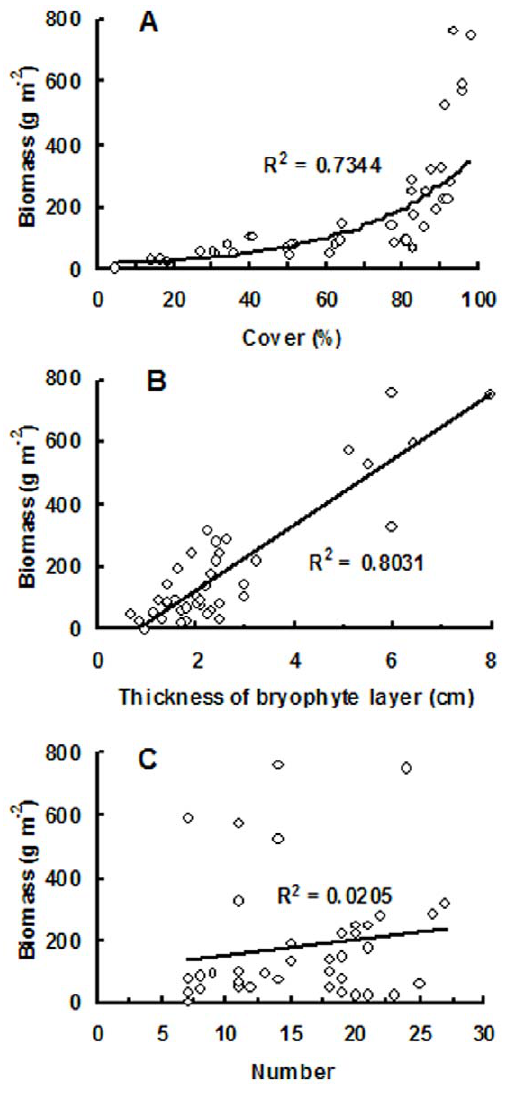
Figure 3. Correlation analysis between bryophyte biomass and A) cover, B) thickness of bryophyte layer, and C) species number.